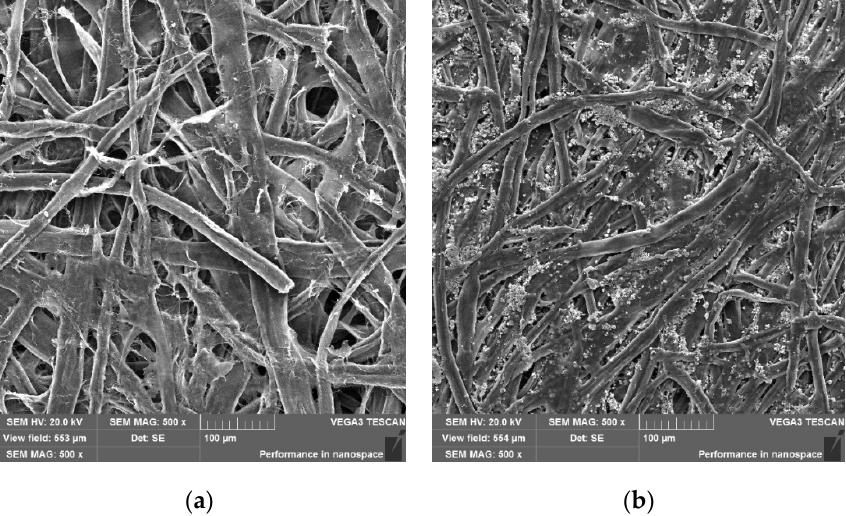
Figure 12. Comparison of the morphology of ( a ) the paper sample containing 20% of PAN–PDA fibres and ( b ) commercial printer paper (magnification × 500; scale 100 µ m; scanning electron microscopy